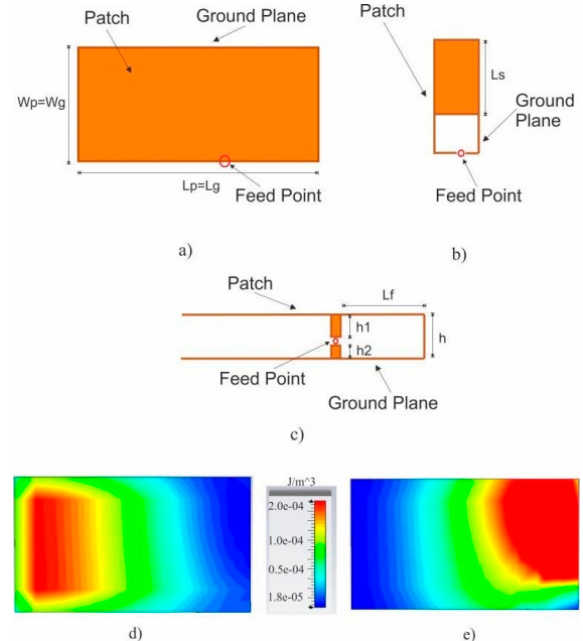
Figure 7. Top view ( a ), and side view ( b ), ( c ) of the considered antenna. Electric ( d ) and Magnetic ( e ) energy densities on the antenna ground plane, at the resonant frequency. W p = W g = 40 mm, L p = L g =